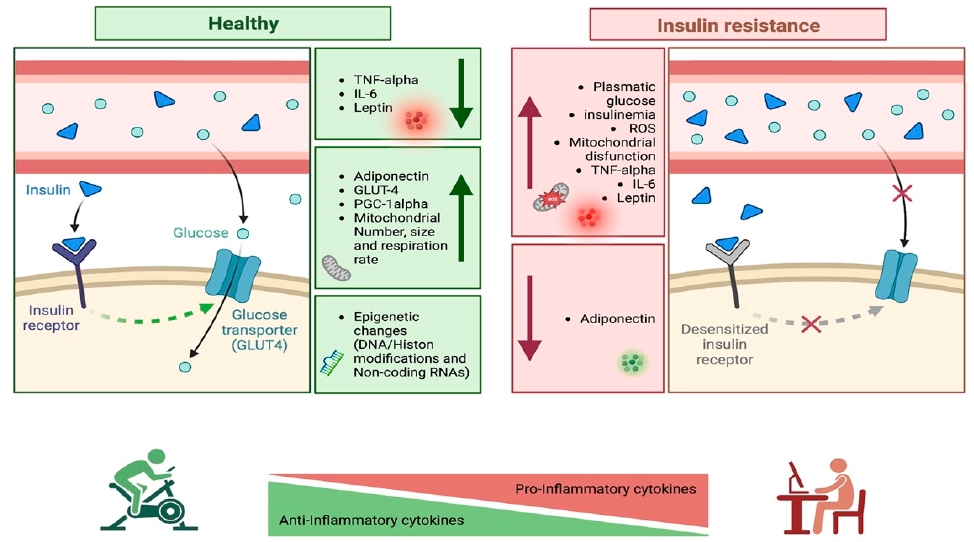
Figure 1. Inflammation, exercise and insulin resistance (created using BioRender).